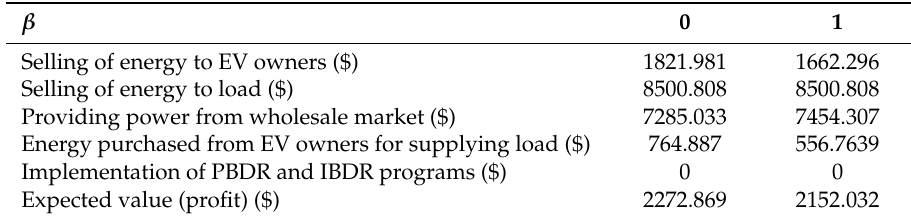
Table 7. The amount of the revenue and cost in TOU programs ( β = 0,